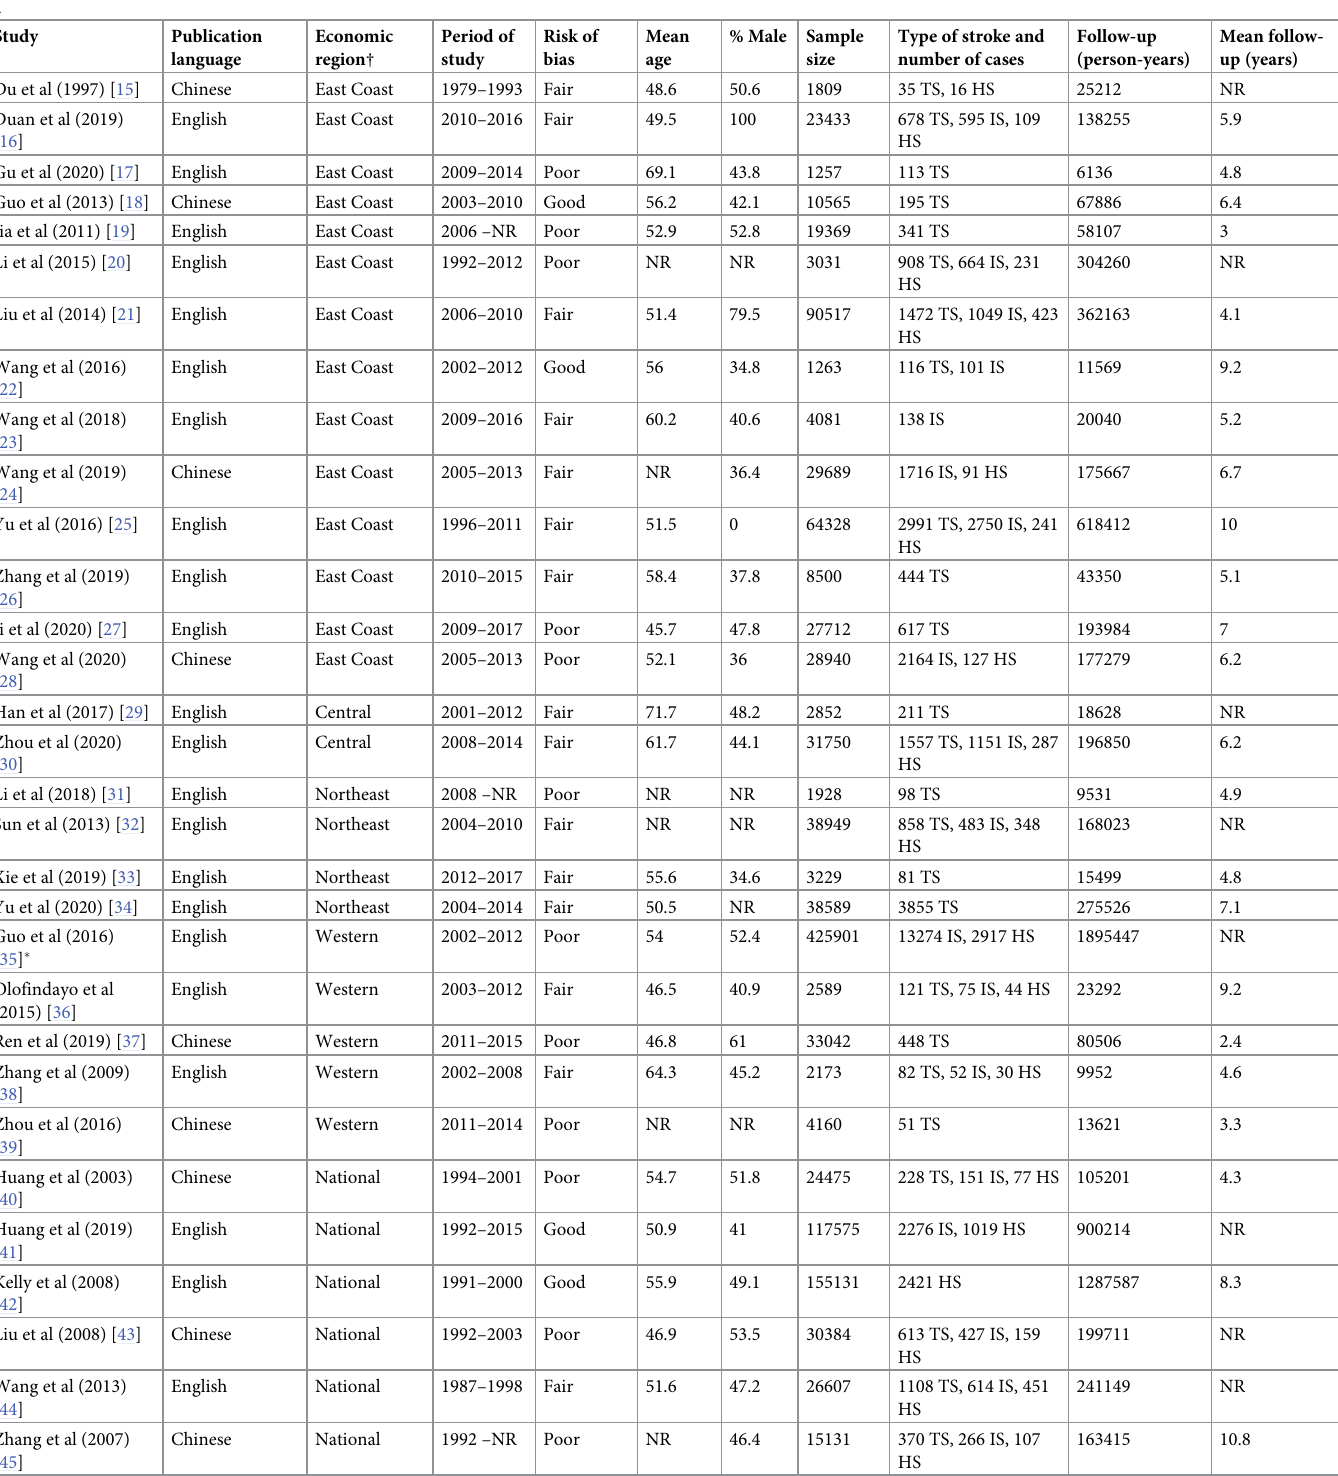
Table 1. a. Description of included studies: incidence. b. Description of included studies: